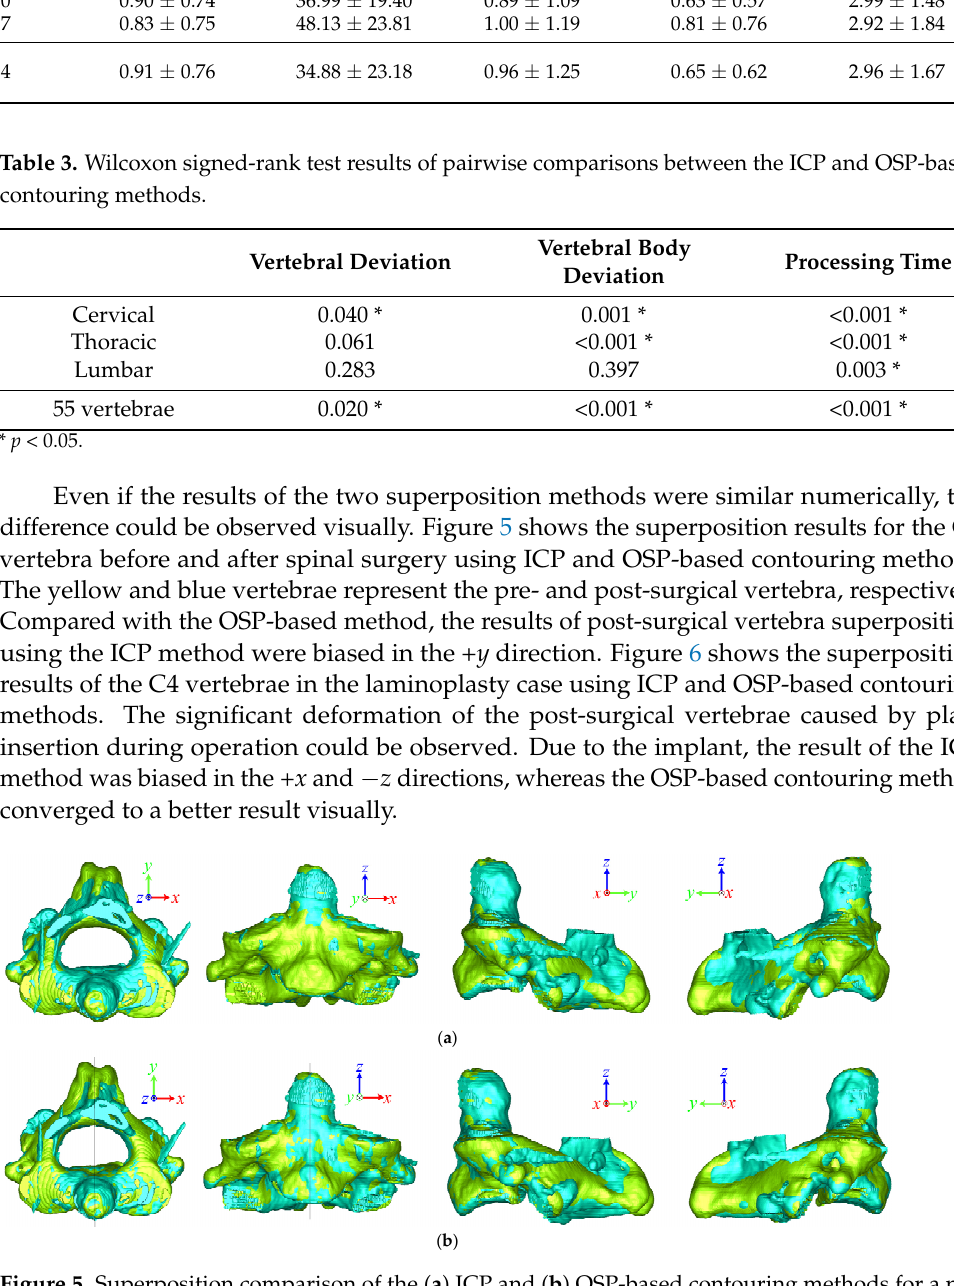
Table 2. Performance and deviation comparisons of the ICP and OSP-based contouring methods.